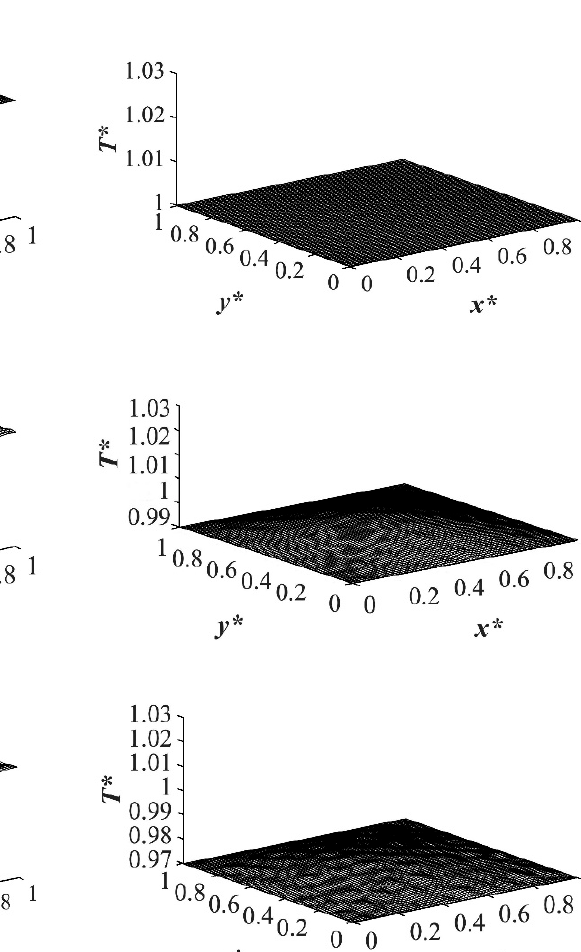
Figure 6. Spatial concentration ( left column) and temperature ( right column) profiles for the off- critical quench to c * = 0.909 at t * = 1.03 × 10 − 6 for three different quench depths of ( a ) T * q1 = 1.0, ( b ) T * q2 = 0.99 ( c ) T * q3 = 0.97.